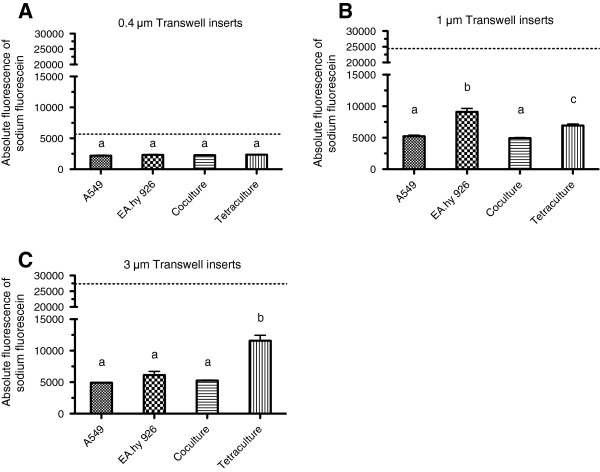
Sodium fluorescein leakage for mono-, co-, and tetraculture in transwell inserts with 0.4, 1 and 3 μm pore size. Medium containing 10 µg/mL of sodium fluorescein was administered to the apical compartment. Medium w/o sodium fluorescein was administered to the basolateral compartment and the leaked fluorescence was measured after 60 minutes incubation at room temperature in the dark. Results obtained for inserts with a pore size of 0.4 μm, 1 μm and 3 μm are given in A, B and C, respectively. The dotted line represents the leakage of transwell inserts w/o cells. Data represents the mean of four independent transwell inserts ± SEM. Groups that are sharing the same letters are not significantly different (P > 0.05).